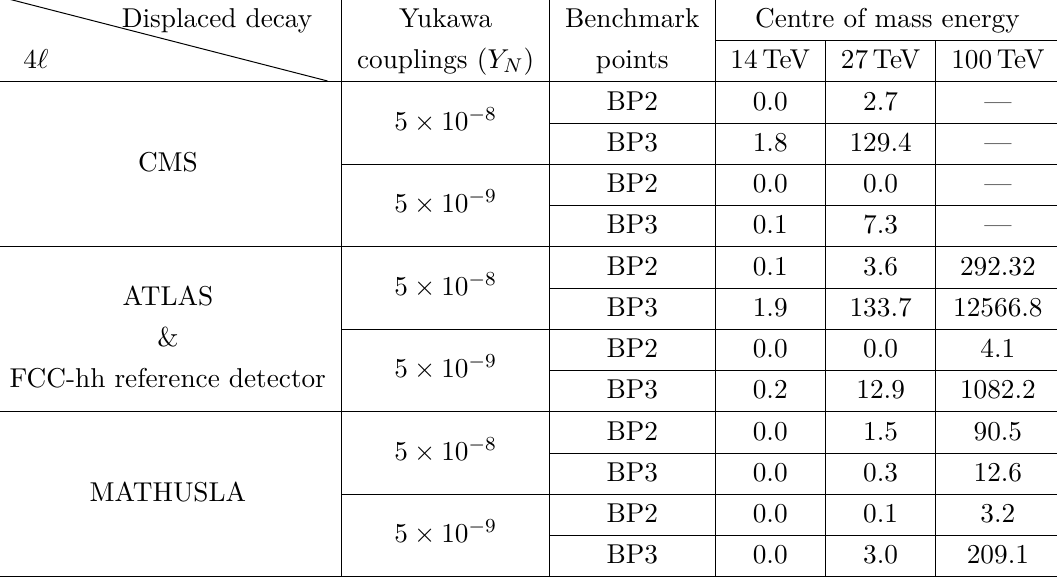
Table 12. Number of events in 4 ‘ final state for the benchmark points, corresponds to the Yukawa couplings ( Y = ) 5 × 10 − 8 and 5 × 10 − 9 , with the center of mass energies of 14 TeV, 27 TeV and N are given separately for CMS, ATLAS, FCC-hh reference detector (for 100 TeV) and MATHUSLA.